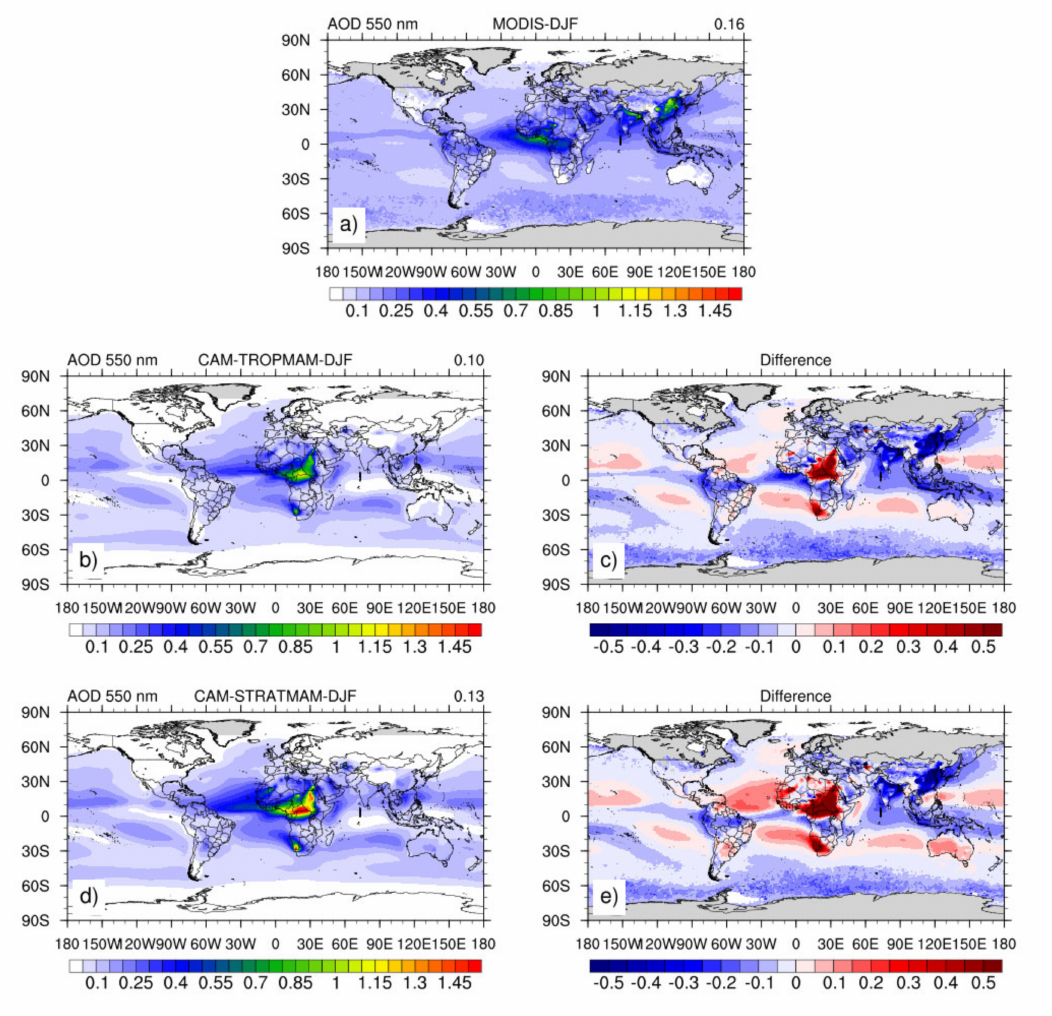
Figure 6. ( a ) AOD observed by MODIS sensor for December-January-February (DJF), in the period of 2010–2014, ( b ) AOD simulated by the CAM5-MAM3 model using tropospheric chemistry and ( d ) tropospheric/stratospheric chemistry mech- anisms. The right side of the figure shows the model difference minus the observation (MODIS), ( c ) for tropospheric chemistry and ( e ) for tropospheric/stratospheric